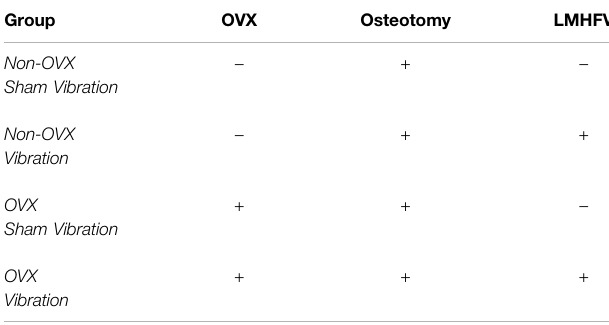
TABLE 1 | Experimental treatment groups per each genotype (ER α fl / fl , ER α fl / fl ; Runx2Cre